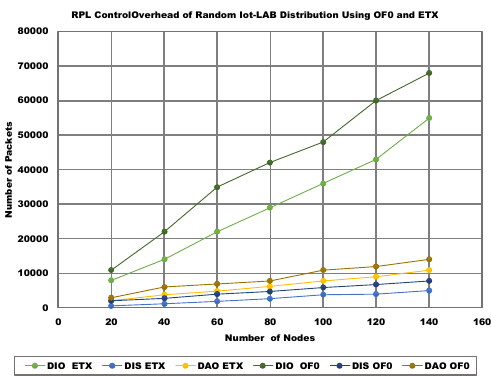
Figure 8. IoT-LAB testbed control traffic Figure 8 . IoT‐LAB testbed control traffic overhead. Figure 8 . IoT‐LAB testbed control traffic overhead.